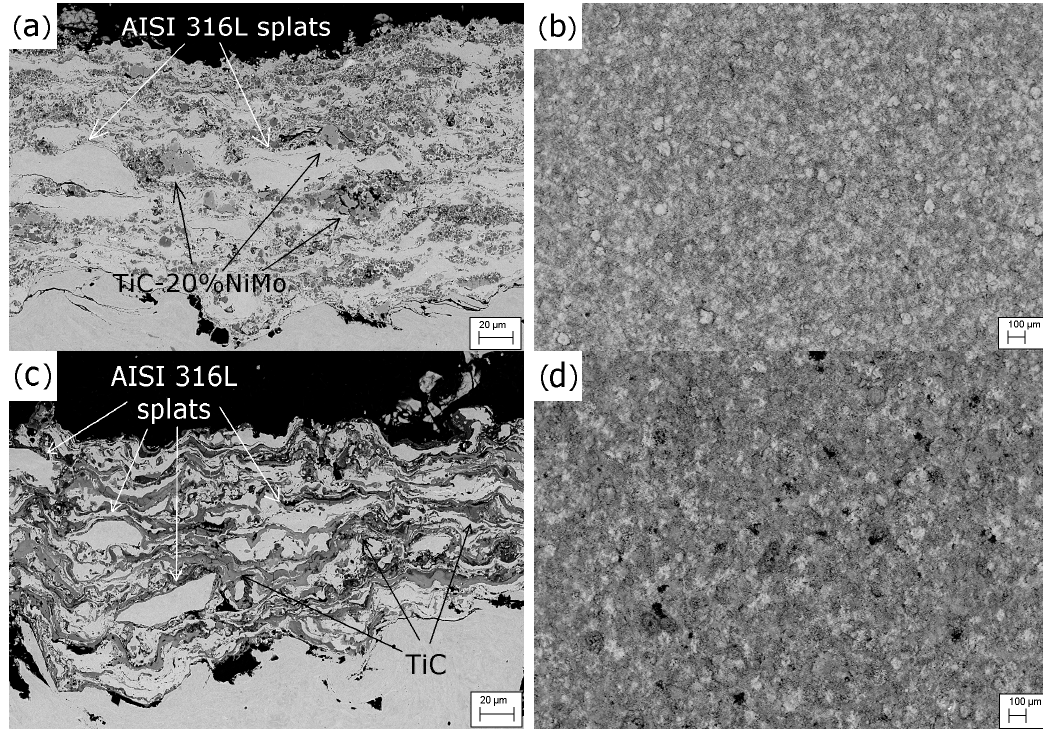
Figure 4. Microstructure (left column) and surface images (right column) of Ti-based HVOF sprayed coatings: ( a , b ) MAS (TiC–20%NiMo) + AISI 316L; ( c , d ) RTS (Ti + C) + AISI 316L.